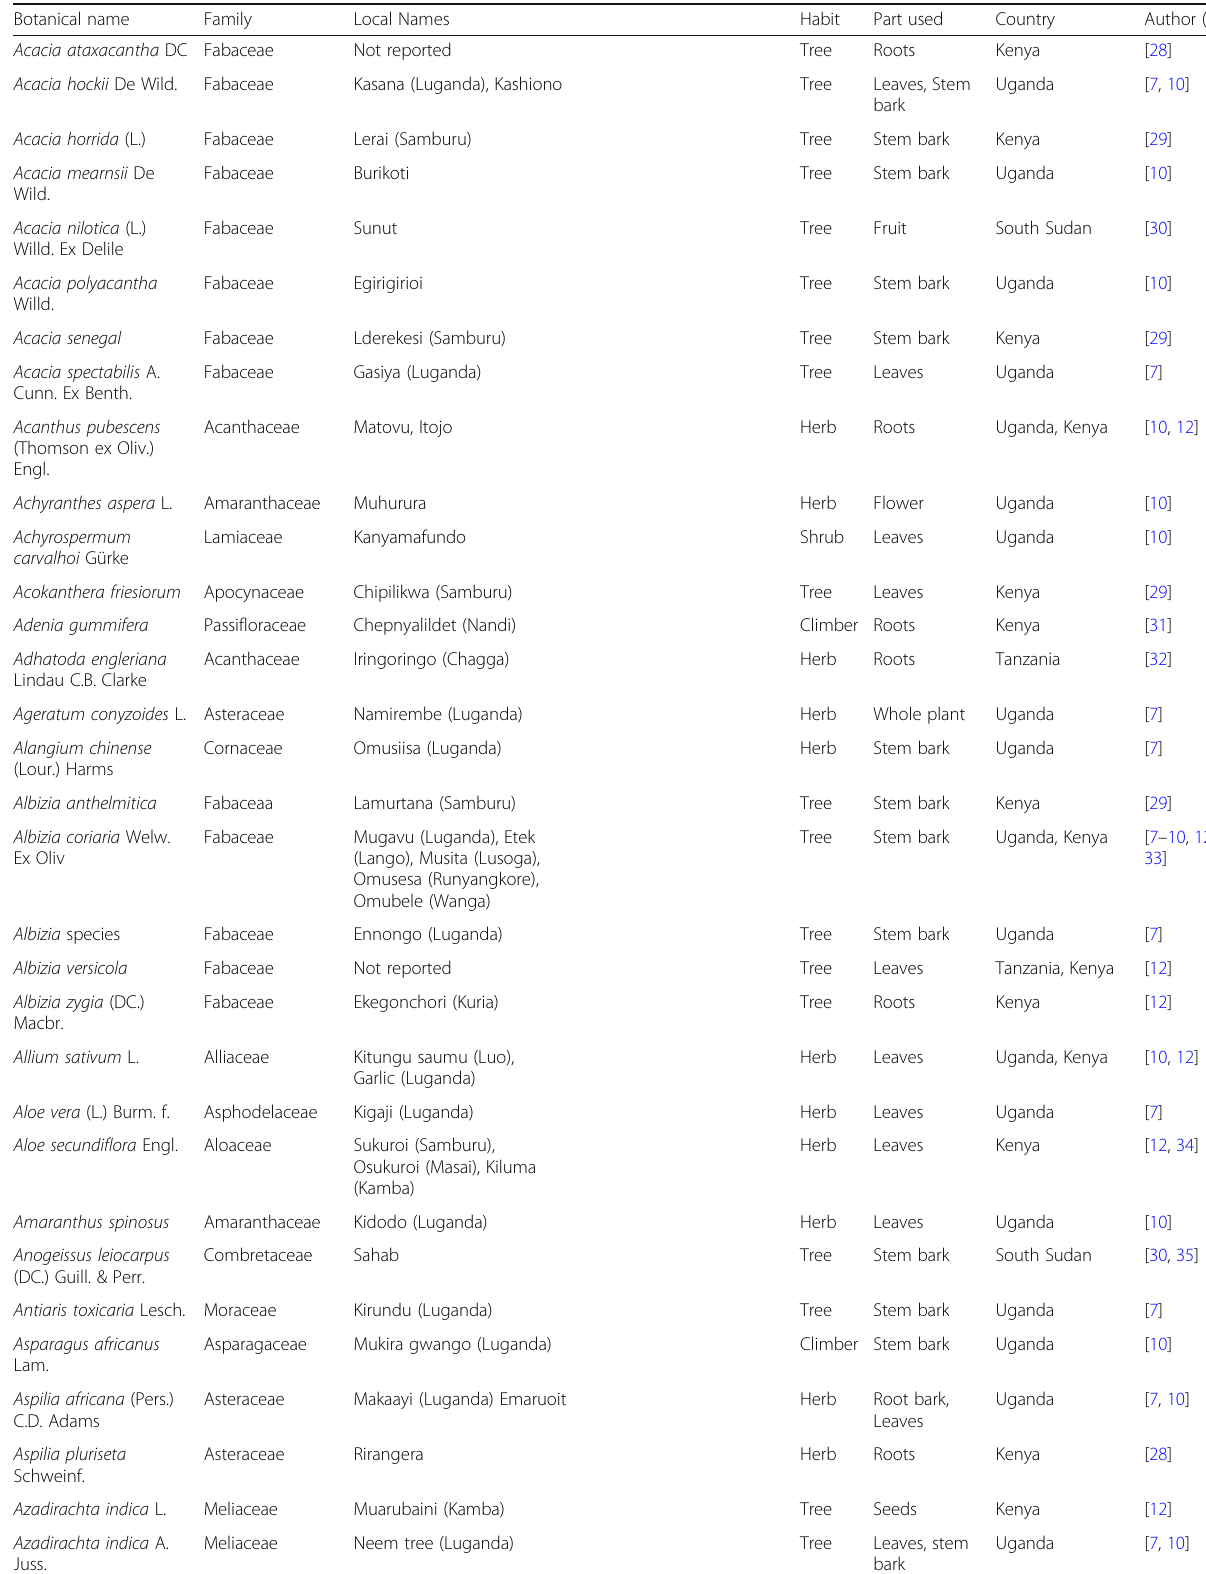
Table 1 Medicinal plants used in treatment of symptoms of TB in East Africa Botanical